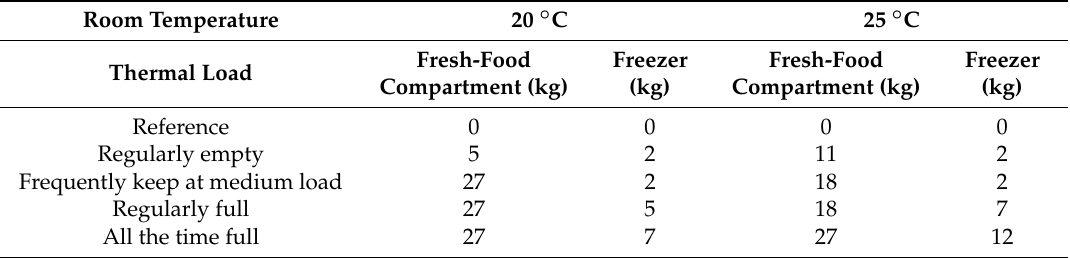
Table 2. Thermal loads in both compartments under two conditions of room